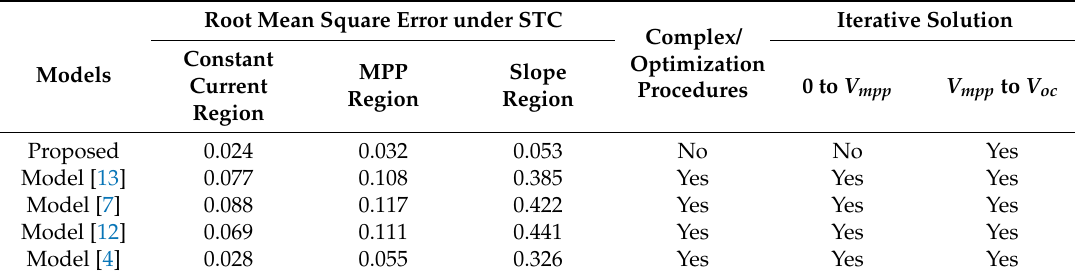
Figure 7. Implementation flowchart of the proposed model. Table 1. Comparison of RMSE and complexity of different